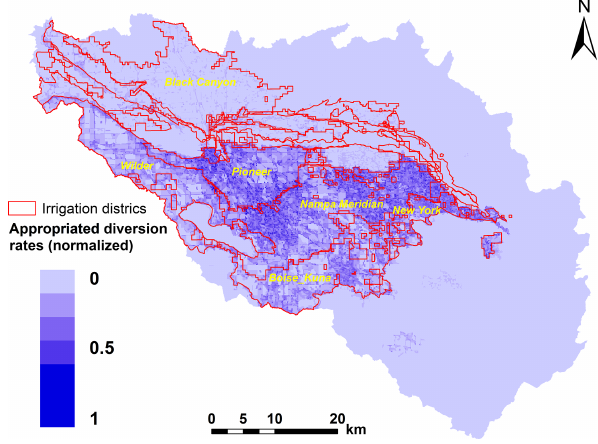
Figure 8. The spatial distribution of the annual allocated irriga- tion water averaged over the simulation period. The domain that is within the thick outline is the Black Canyon irrigation district, which receives additional irrigation water from outside of the do- main, where the water allocation is underestimated.